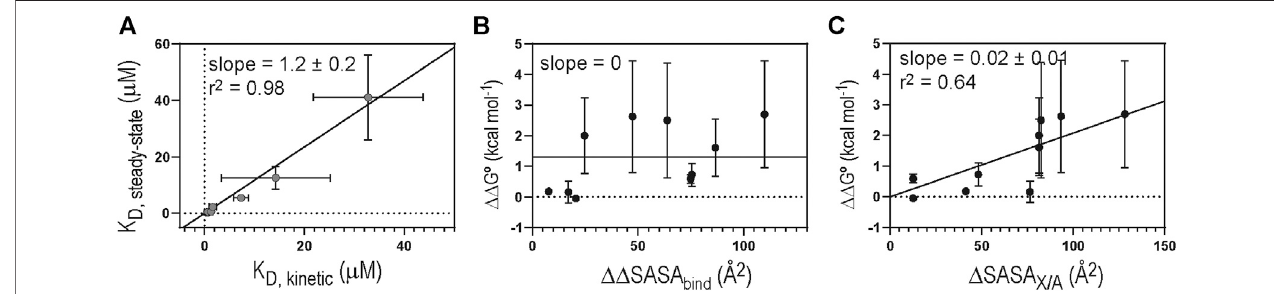
FIGURE4|(A) CorrelationbetweenK D valuesderivedbysteady-stateandkineticmethods.Soliddiagonallinerepresentsthebestlinearregressioncurve.Plotsof (B) ΔΔ G ° vs. ΔΔ SASA bind and (C) ΔΔ G ° vs Δ SASA X/A . Solid lines represent the linear regression curves selected by hypothesis testing between the null (slope (cid:2) 0) and alternative (slope ≠ 0) hypotheses. Critical α value was 0.05 for the hypothesis test